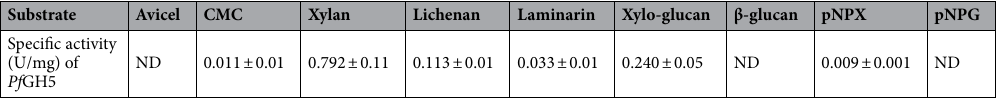
Table 1. Substrate specificity of the recombinant Pf GH5 on various polysaccharides. ND no detected activity.